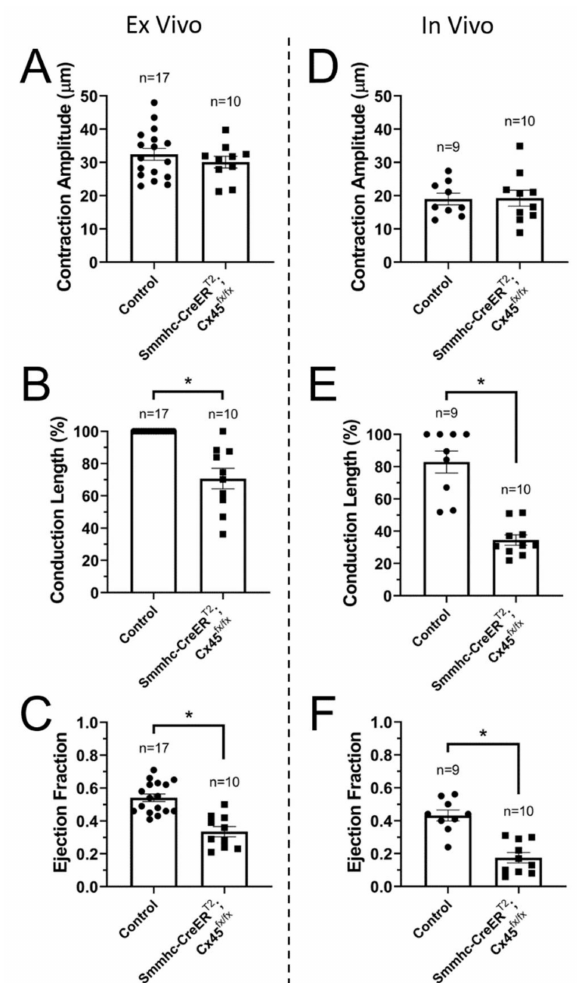
Figure 3. Ex vivo and in vivo assessment of the contractile function of lymphatic vessels from control (C57BL / 6J WT and Cx45 fx / fx combined) and smooth-muscle Cx45-deficient (Smmhc-CreER T2 ;Cx45 fx / fx ) mice: ( A , D ) Contraction amplitude; ( B , E ) Conduction length; and ( C , F ) Ejection fraction for ex vivo and in vivo protocols respectively. Ex vivo, contractions were recorded under 2 cmH 2 O of intraluminal pressure (P upstream = P downstream ). * Indicates statistical significance ( p < 0.05) between control and SM-Cx45-deficient